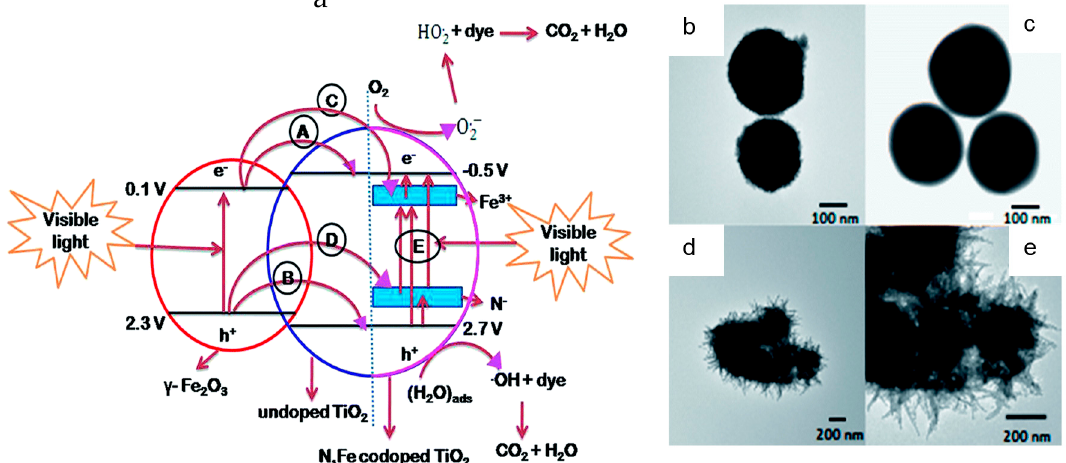
Figure 3. ( a ) Charge transfer mechanism in γ‐ Fe 2 O 3 /Fe,N ‐ TiO 2 (Reproduced with permission